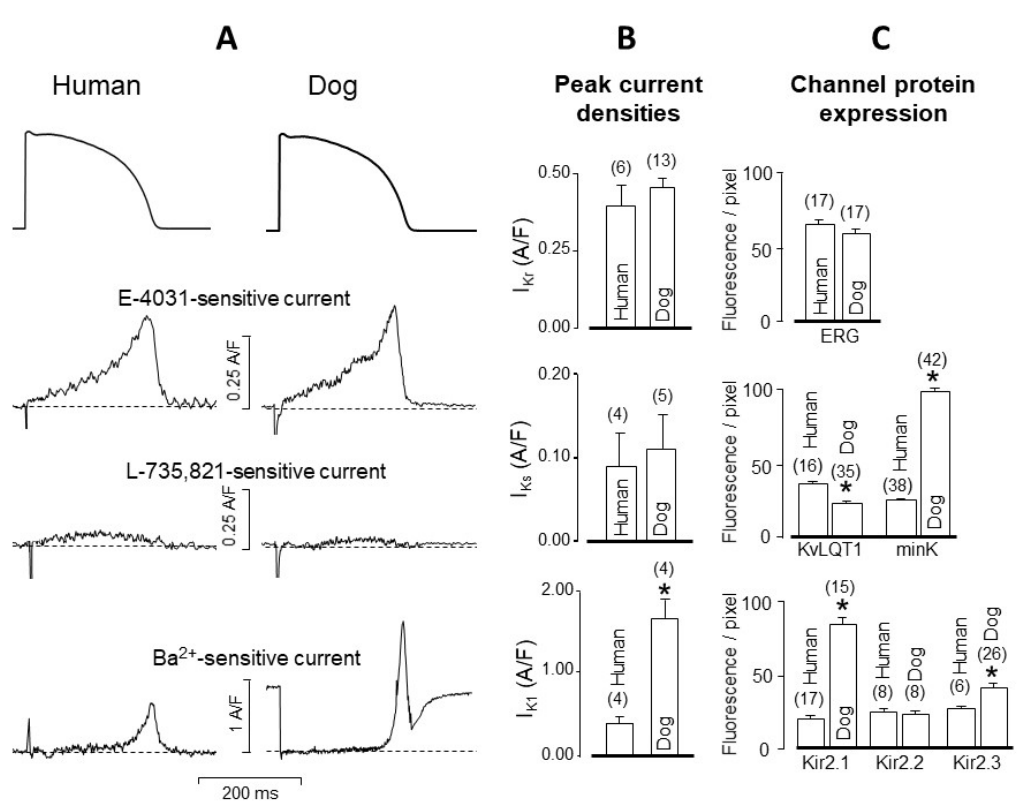
Figure 5. Comparison of peak I Kr , I Ks , and I K1 current densities in human and canine ventricular myocytes under action potential voltage clamp conditions ( A , B ). I Kr , I Ks , and I K1 were excised by 5 µ M E-4031, 0.1 µ M L-735,821, and 500 µ M BaCl 2 , respectively. ( C ) Expression of the main channel proteins in human and canine ventricular myocardium. Columns and bars are mean ± SEM values, ( n ) denotes the number of myocytes in ( B ), and myocardial samples in ( C ), the asterisks (*) indicate significant differences between human and canine data. (Data from reference